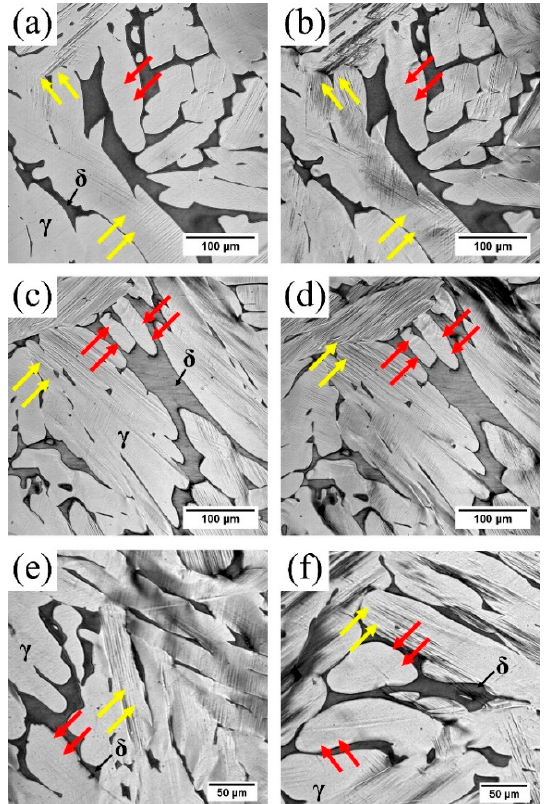
Figure 7. Effects of ferrite shapes on blocking the slip bands in Z3CN20.09M CDSS. Figure ( a , b , e , f ) were the microstructure snapshots during the in situ tensile test using the samples under the “aged 2000 h, 320 ◦ C” condition. Figure ( c , d ) were the microstructures from the sample with the “annealed 3 h, 320 ◦ C” condition. The tensile axis is along the horizontal direction in all the figures. γ denotes the austenite phase, and δ is the ferrite phase.